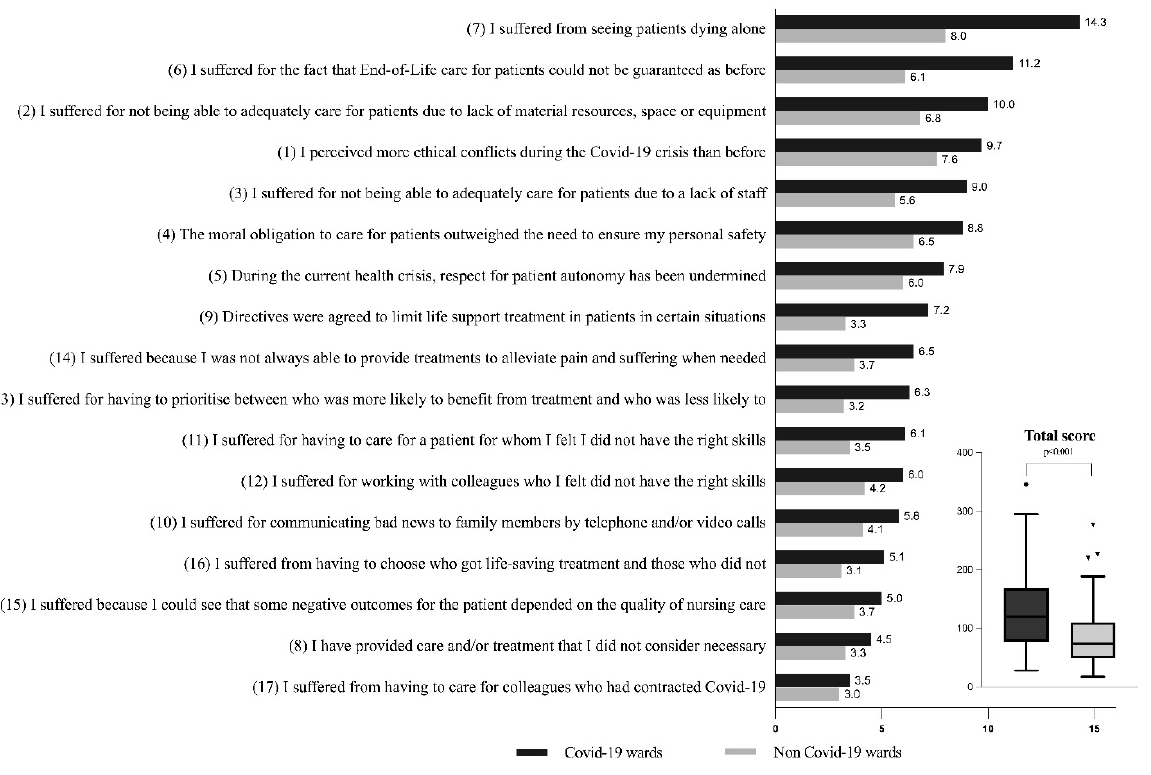
Figure 1. Ethical conflict items, comparison between Covid-19 and non-Covid-19 wards (values are shown as means). Psychological Distress Overall, the nurses in our sample showed a moderate level of psychological distress (median = 15 [7–26]).